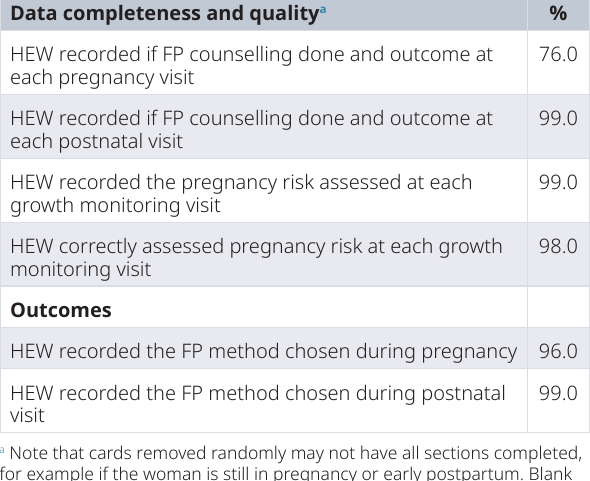
Table 2. Completeness and quality of modified maternal, newborn and child health Cards (n = 180). Data completeness and quality